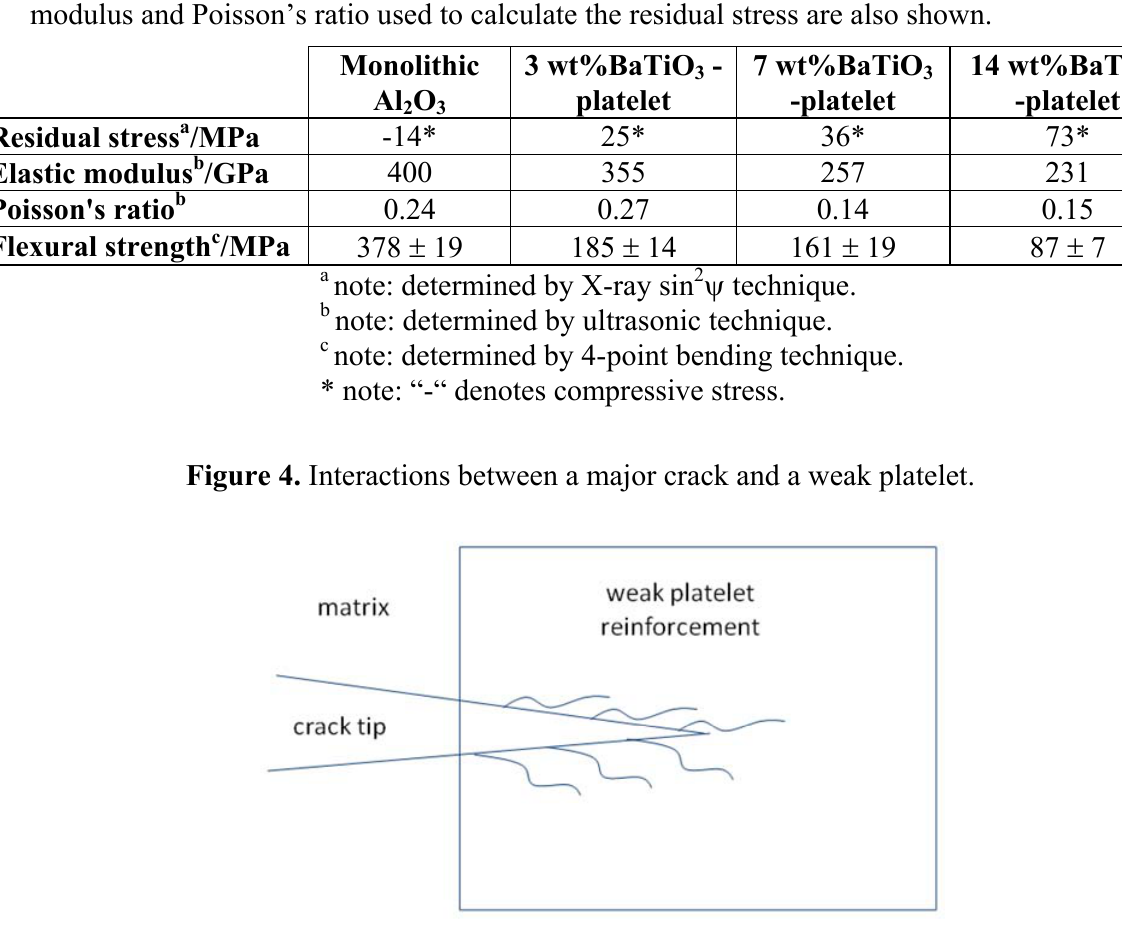
O /BaTiO -platelet composites. The elastic 2 3 3